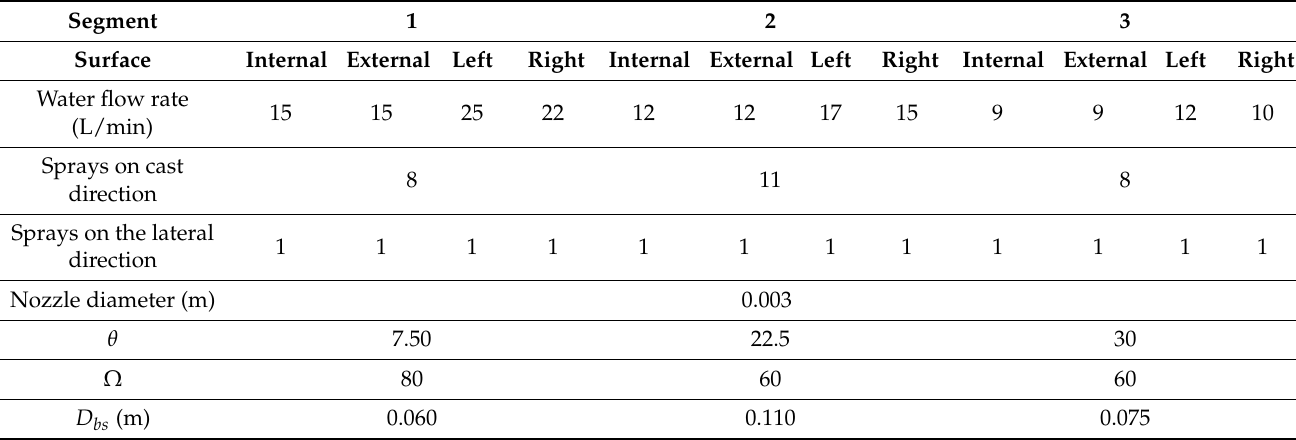
Table 5. Operation conditions of the SCS (segments 1, 2, and 3), case